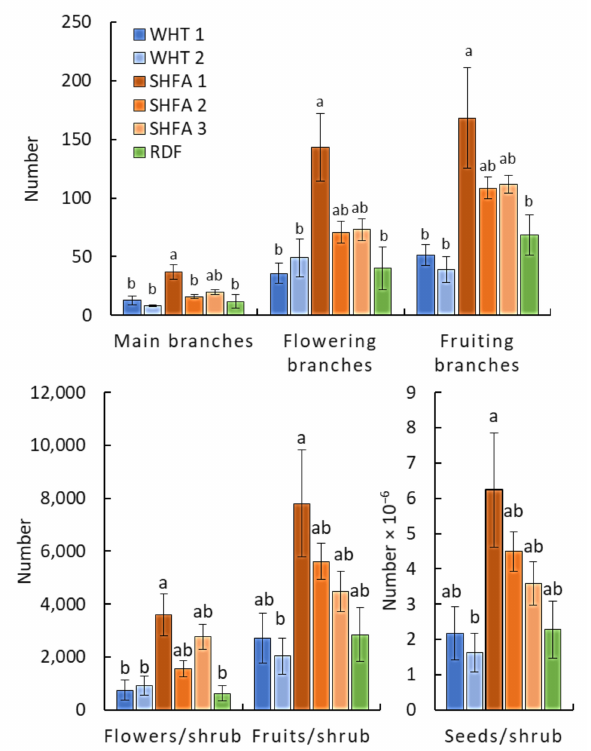
Figure 3. Variation in the different measurements of Nicotiana glauca shrubs among the studied